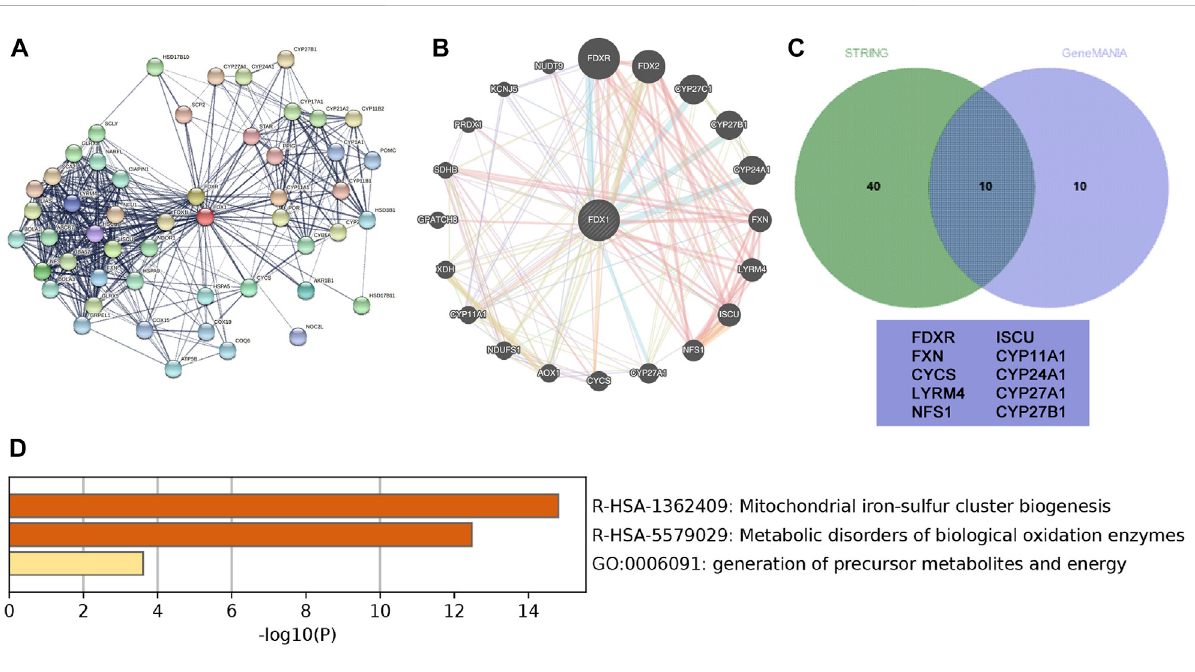
FIGURE 7 Protein-protein interaction (PPI) network of FDX1 and related genes. (A) STRING-created PPI network analysis of the FDX1 gene (B) GeneMANIAC-created PPI network analysis of the FDX1 gene. (C) The Interactive Venn diagram depicts the overlapping interactive 10 proteins with FDX1 based on GeneMANIA and STRING. (D) Functional analysis of the interactive 10 proteins using a bar